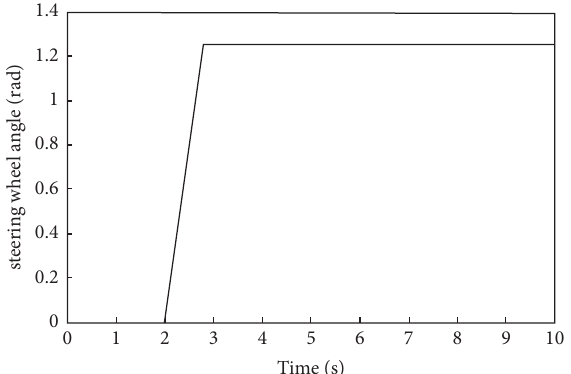
Figure 10: Steering wheel angle step